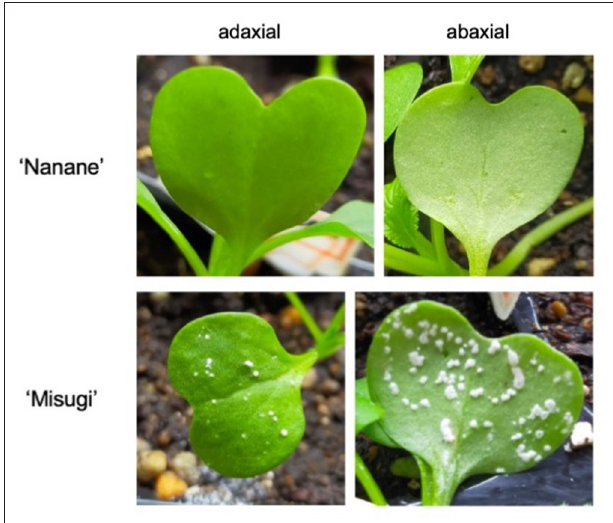
FIGURE 1 | Phenotype caused by A. candida 10 days after inoculation at the seedling stage of komatsuna ( Brassica rapa subsp. perviridis ). Susceptible cultivar: “Misugi,” Resistant cultivar: